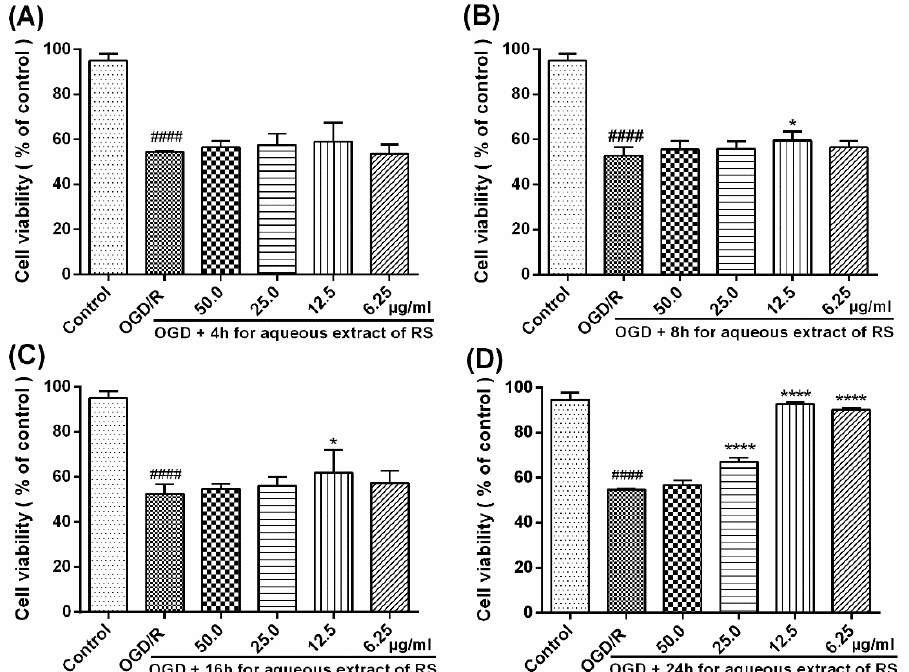
Figure 2. Effects of Radix Scrophulariae aqueous extract on the viability of PC12 cells after OGD/R. After PC12 cells were exposed to 2 h of OGD following 24 h of reperfusion, cell viability was significantly decreased. ( A ) Incubation of PC12 cells with different concentrations of RSAE (5.0, 12.5, 25.0 and 50.0 µ g/mL) alone for 4 h did not affect cell viability. ( B , C ) Pretreatment with RSAE (12.5 µ g/mL) for 8 h and 16 h significantly improved cell viability. ( D ) After PC12 cells were exposed to 2 h of OGD following 24 h of reperfusion, pretreatment with RSAE (5.0, 12.5, 25.0 and 50.0 µ g/mL) for 24 h significantly improved cell viability. Mean values ± standard error of the mean (n = 6); * p < 0.05, **** p < 0.00001 versus OGD/R group; # p < 0.05, ## p < 0.01, #### p < 0.0001 versus control group.